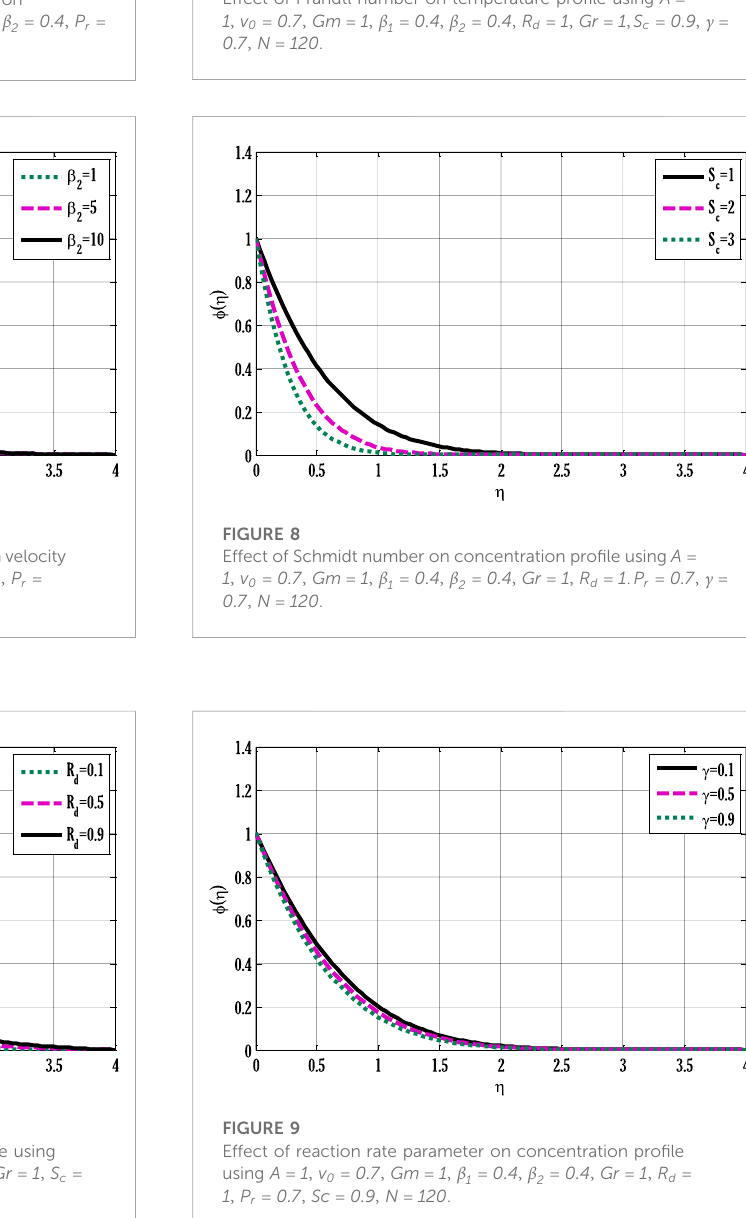
FIGURE 7 Effect of Prandtl number on temperature pro fi le using A (cid:1) 1